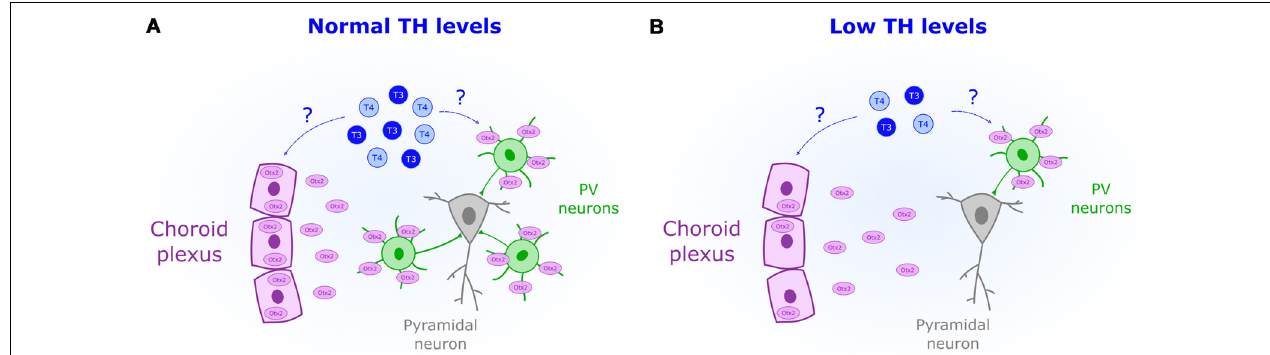
FIGURE 2 | Reduced perinatal levels of THs (blue) are associated with a decreased presence of parvalbumin-positive neurons (PV). (A) Normal levels of TH could act as permissive signals for CP onset by increasing Otx2 (purple) synthesis in the choroid plexus. (B) Downregulation of Otx2 expression in the choroid plexus could mediate the observed impairment in PV maturation under low levels of